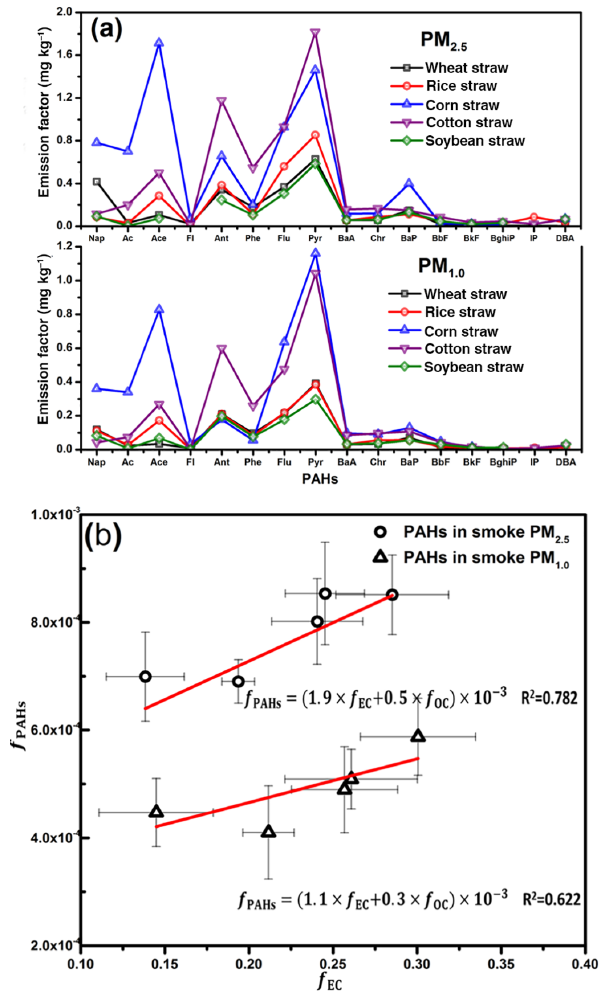
Figure 3. (a) Emission factors of 16 US EPA priority PAHs in smoke PM 2 . 5 and PM 1 . 0 ; (b) expulsion–accumulation of PAHs in OC and EC of smoke PM 2 . 5 and PM 1 . 0